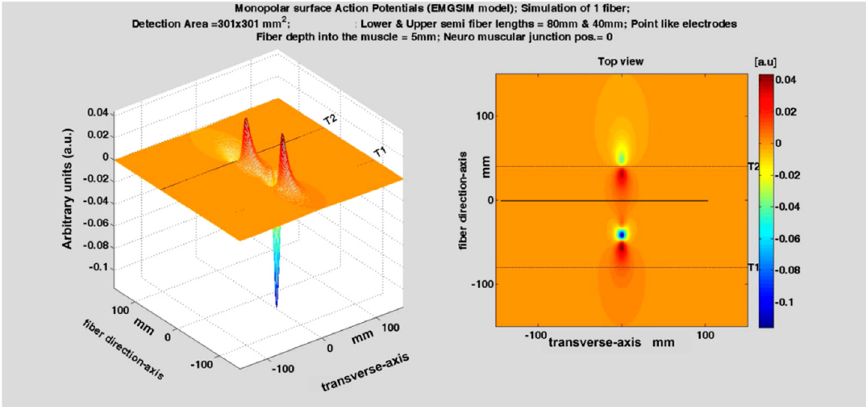
Figure 11. Slow-motion simulation of the generation, propagation, and extinction of an action potential produced by a single fiber whose neuromuscular junction is not in the middle of the fiber. Observe the two end-of-fiber effects taking place at different times at the fiber-tendon junctions T1 and T2. They generate two sharp non-propagating transients in the sEMG signal. For a motor unit, the end-of fiber effect(s) may be smaller and less sharp, depending on the scatter of the fiber terminations. (See animation in Supplementary Materials, Sup5). Reproduced from https://www.robertomerletti.it/en/emg/material/teaching/module9.